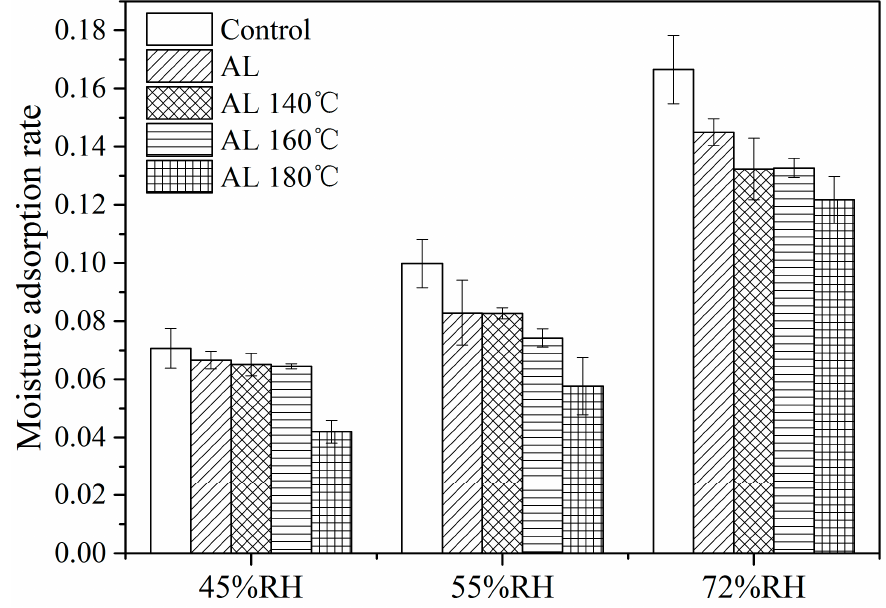
Figure 7. Moisture adsorption rate of the samples during the first 24 h.